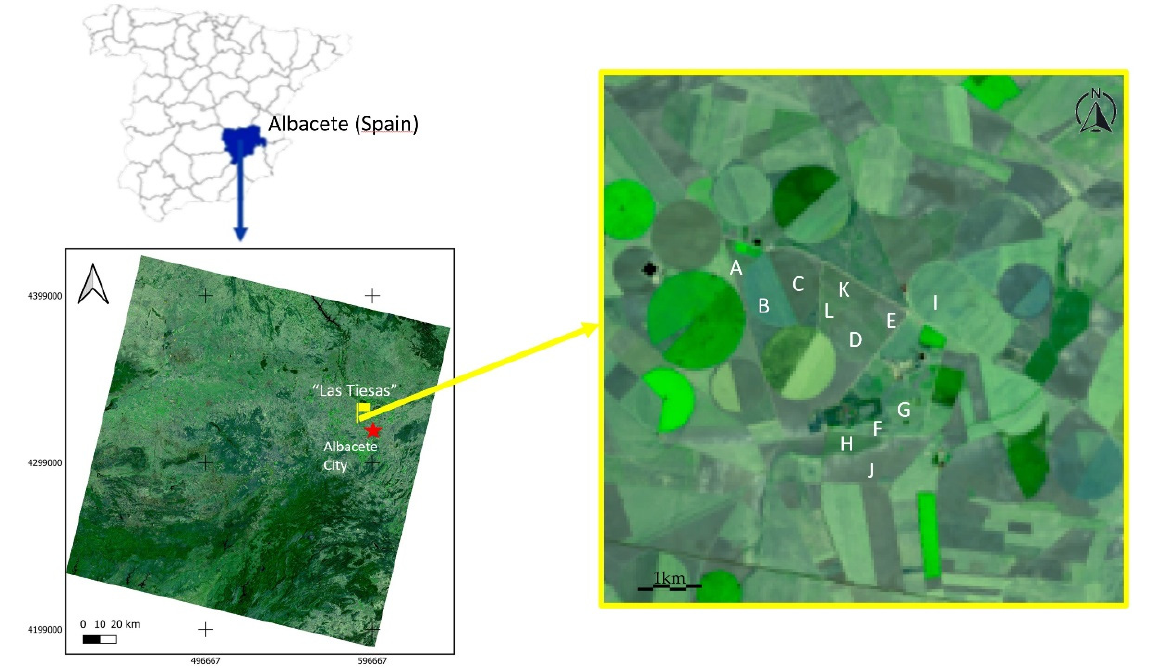
Figure 3. Location and overview of the “Las Tiesas” experimental farm. RGB (B6, B5, B4) subset of Landsat 8/OLCI scene corresponding to date 24 July 2018. Superposed letters (A–L) in the image represent the different validation sites. Crops and locations are listed in Table 2. A total set of 11 L8/TIRS scenes was selected for this work. All are cloud-free images with available ground data for the evaluation. Collection 2 Level-1 and Level-2 L8 products were downloaded and processed, with a pixel size of 30 m. Table 2 lists the ground